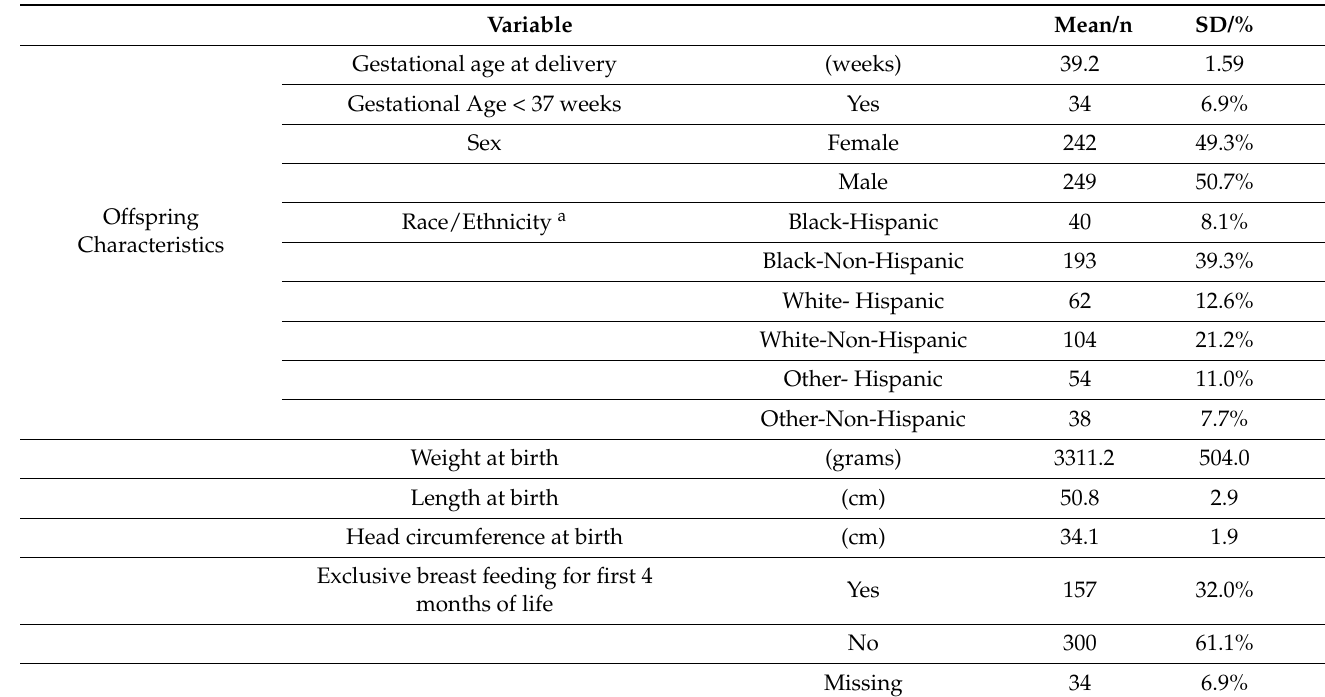
Table 1. Cont. Variable Mean/n SD/%